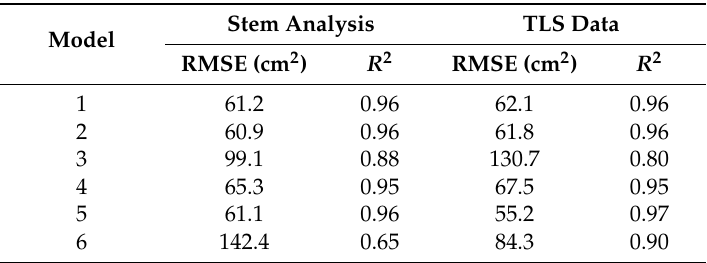
Table 6. Statistics derived after fitting six taper